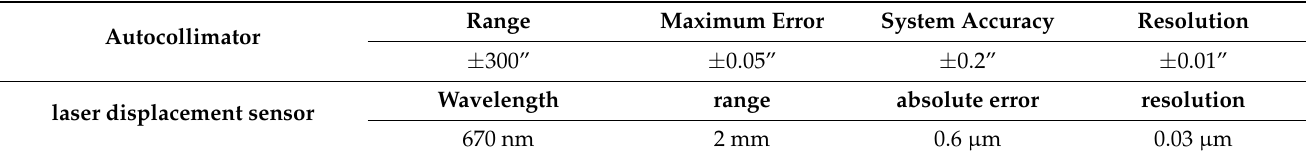
Table 3. The measurement results before and after the compensation of the six DOF motion errors of the rotary axis.